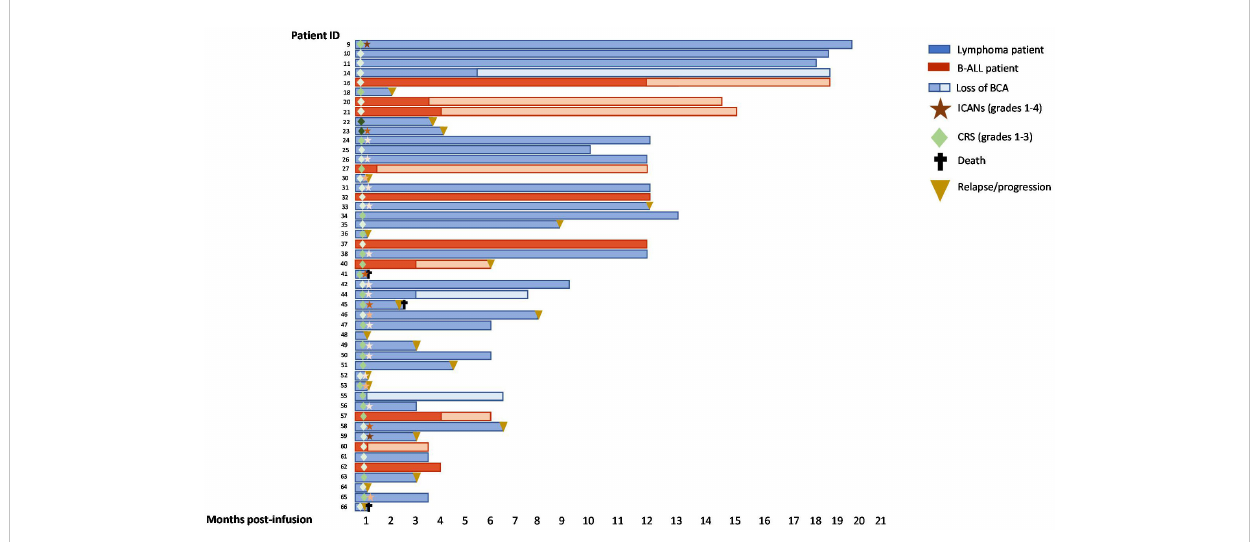
FIGURE 4 Swimmer plots of 48 patients with B-ALL or lymphoma after CD19 CAR-T cell infusion. BCA (B-cell aplasia). CRS and ICANs grades are depicted from 1-4 according to the intensity of the